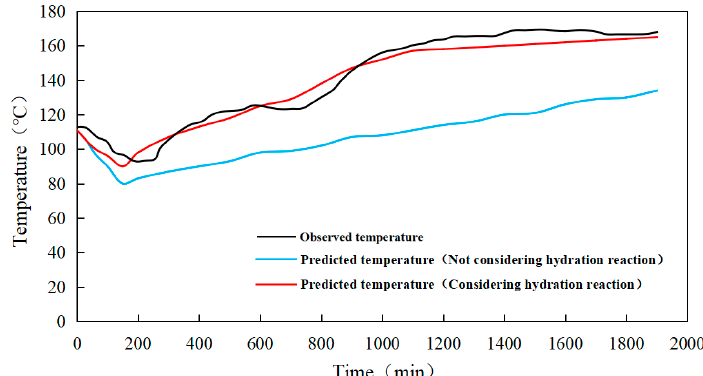
Figure 6. Comparison between the calculated temperature and the measured results.